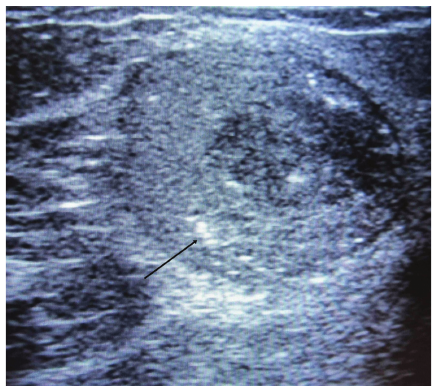
Figure 5: USG of right breast showing hypoechoic, heterogeneous mass lesion with echogenic foci (arrowhead).